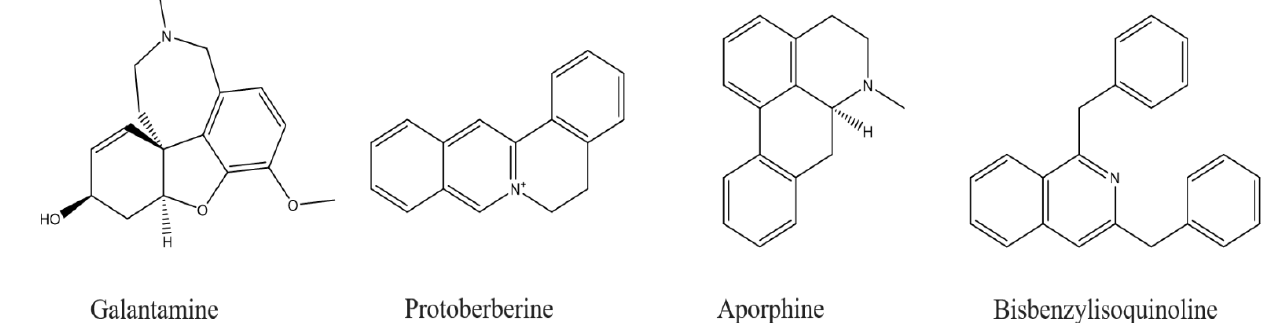
Figure 2. Structures of isoquinolines with anti-Alzheimer effects.